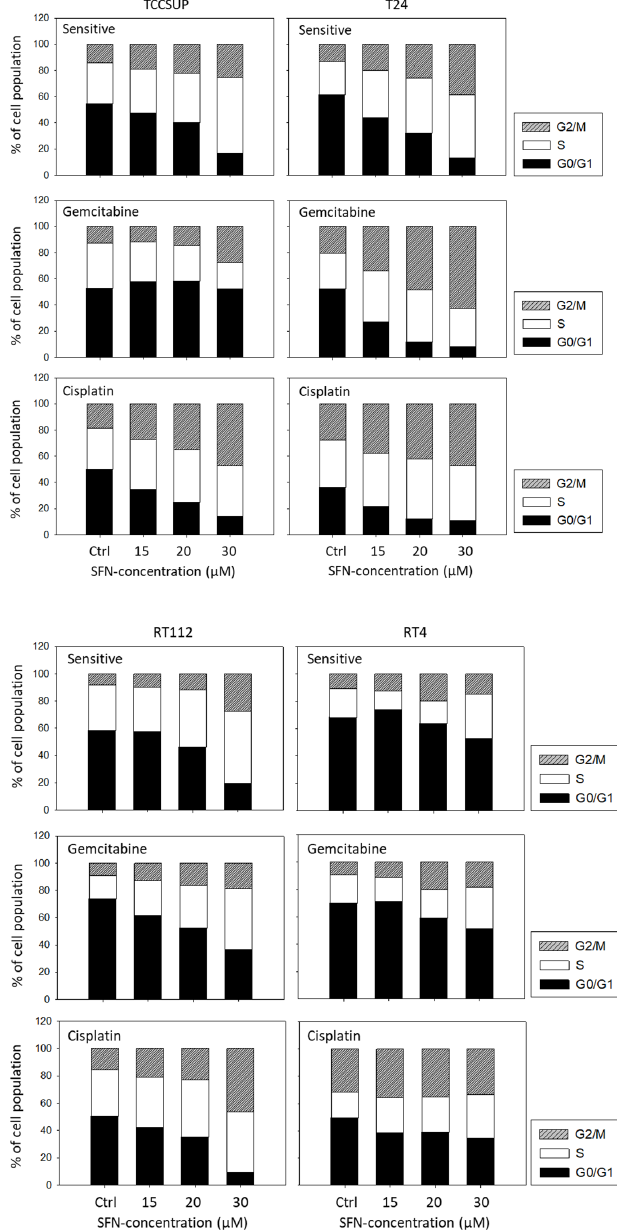
Figure 6. Cell cycle distribution in sensitive and cisplatin- or gemcitabine-resistant TCCSUP, T24, RT112, and RT4 bladder cancer cell lines following SFN exposure (15, 20, 30 µM). Controls (Ctrl) remained untreated. Cells in each phase are shown as a percentage. One representative of three separate experiments is shown.